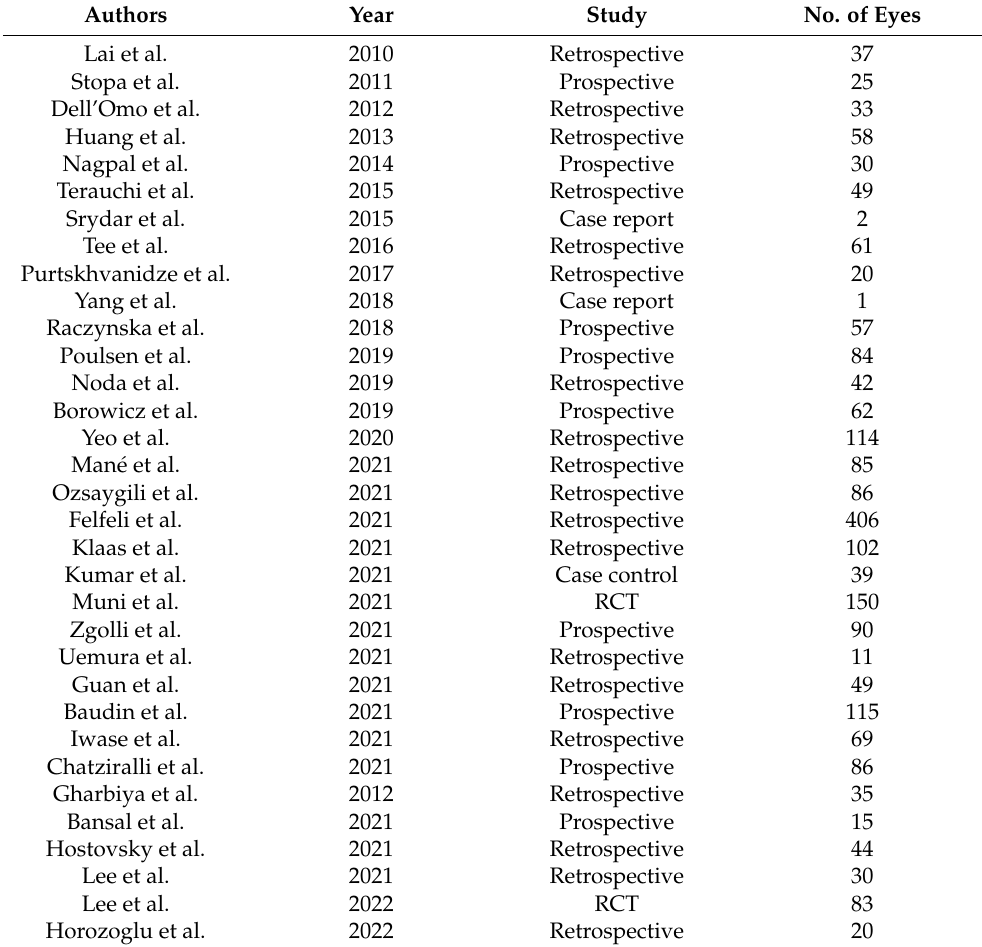
Table 1. Spectral-domain and swept-source